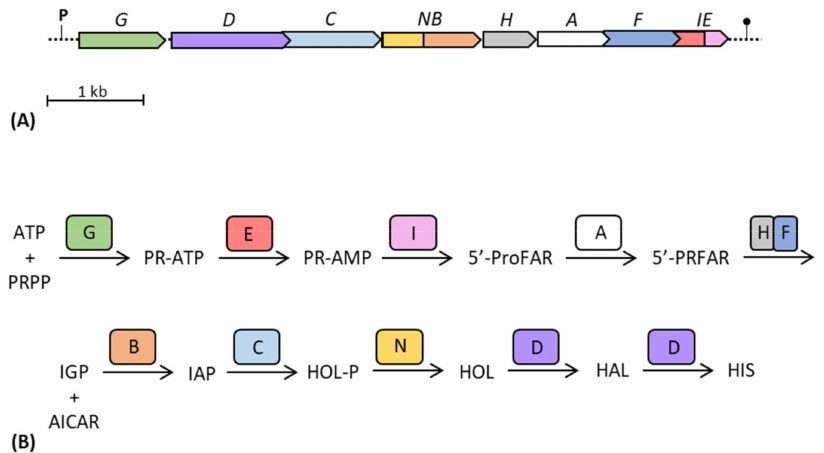
Figure 5. Schematic representation of the gene structure of the his operon of E. coli ( A ) and of the steps of the histidine biosynthetic pathway ( B ). Adapted from [58]. ATP: